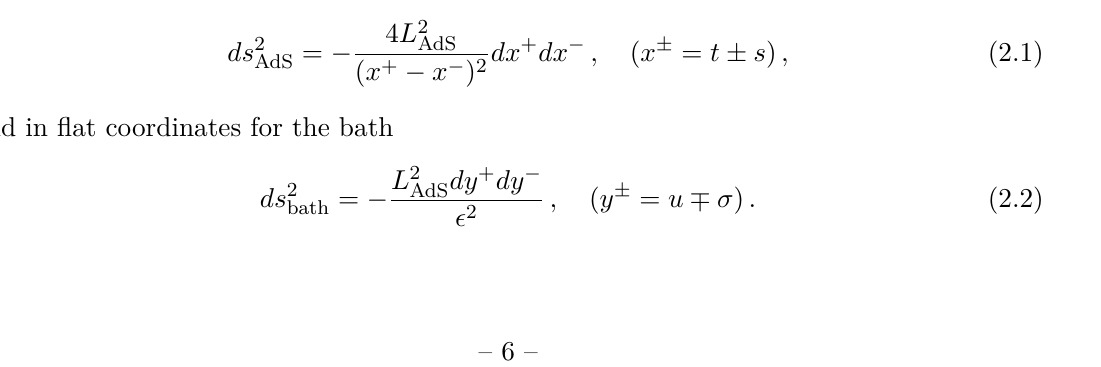
Figure 2 . A cartoon illustration of the three phases for the entanglement entropy of QM QM , (a semi-infinite interval in) the thermal bath, and the (entire) bath purifier, after the quench L where QM is connected to the bath. The darker colors indicate the true generalized entropy, while R the lighter colors indicate the general shape of each of the branches slightly beyond the regime where it provides the minimal value for the generalized entropy. Below the plot is a sketch of the shape of the extremal HRT surfaces in AdS 3 which contribute to the generalized entropy in each